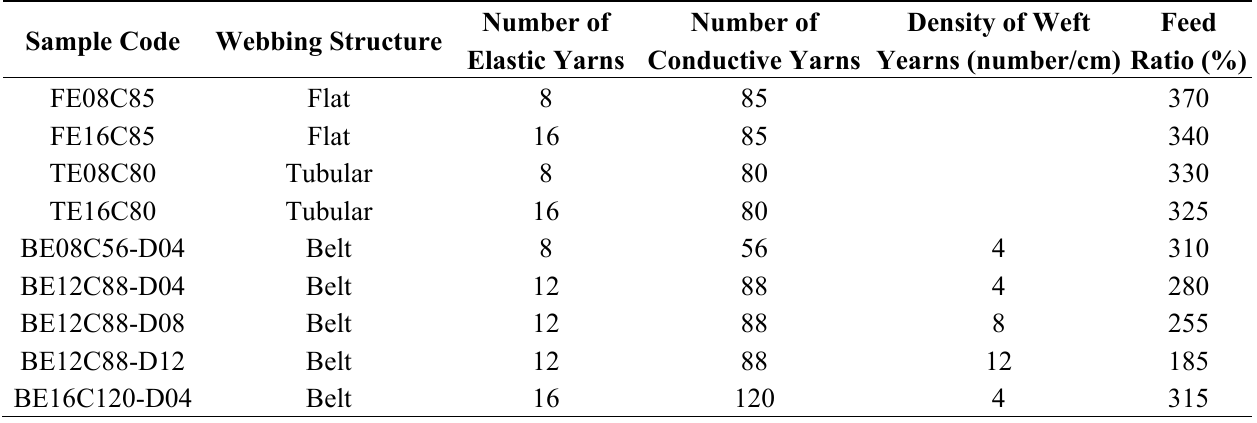
Table 1. The number of elastic yarns and conductive yarns, the density of the weft yarns, and the feed ratio of the conductive yarns of the samples.